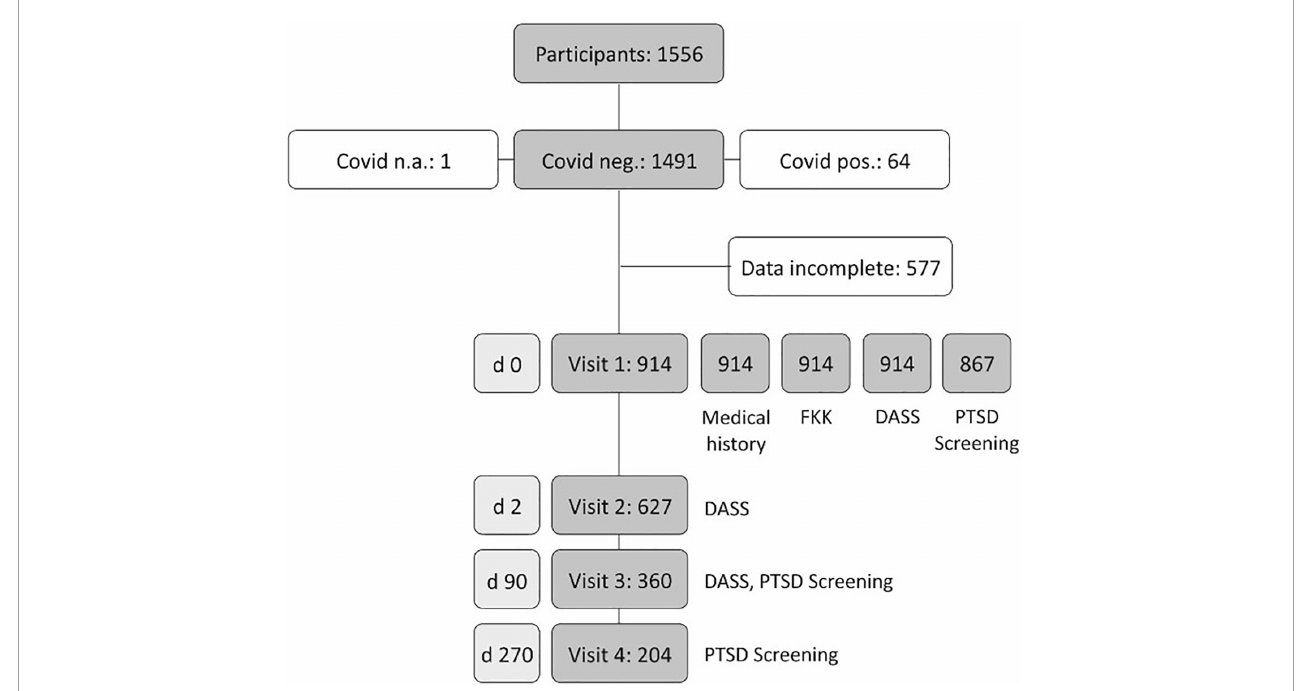
FIGURE2 Case numbers and drop-out rates in the Vienna post-traumatic stress disorder (PTSD) survey.